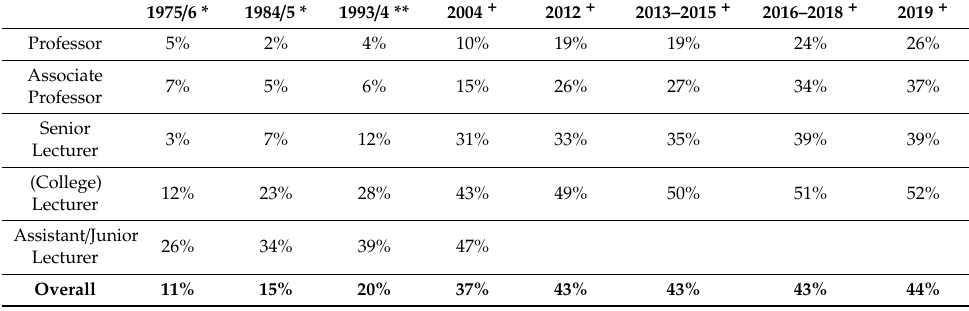
Table 1. Women faculty (full-time) as a percentage of those at each level in Irish Universities 1975 / 76 to